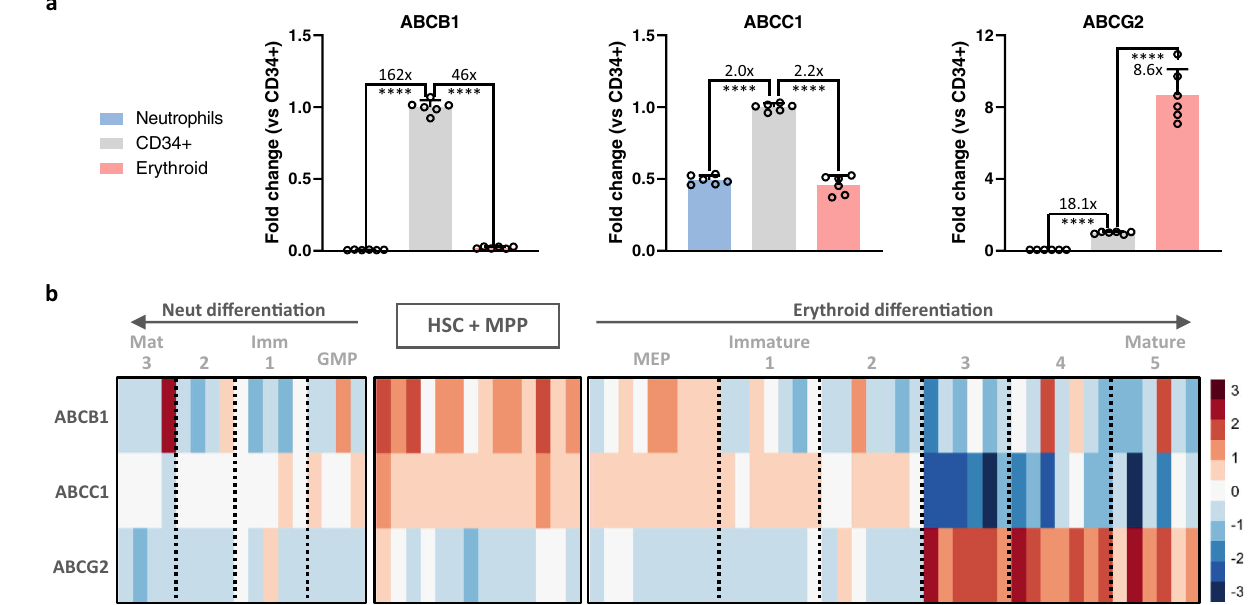
Fig. 4 | Developing neutrophils lose ABC transporters while developing ery- throid cells switch ABC transporters. a Neutrophil, CD34 + progenitor, and ery- throid populations were FACS sorted from 10 day hematopoietic cultures and quantitative real-time PCR was used to measure relative expression of B1, C1, and G2.BargraphsdisplayfoldchangenormalizedtoGAPDHandtheCD34 + progenitor population. Mean and SD are shown; n =6, from 2 independent experiments. **** p <0.0001, 1-way ANOVA of normalized cycle threshold counts for each gene with post-hoc analysisviaDunnett ’ stest to compareerythroidand neutrophil